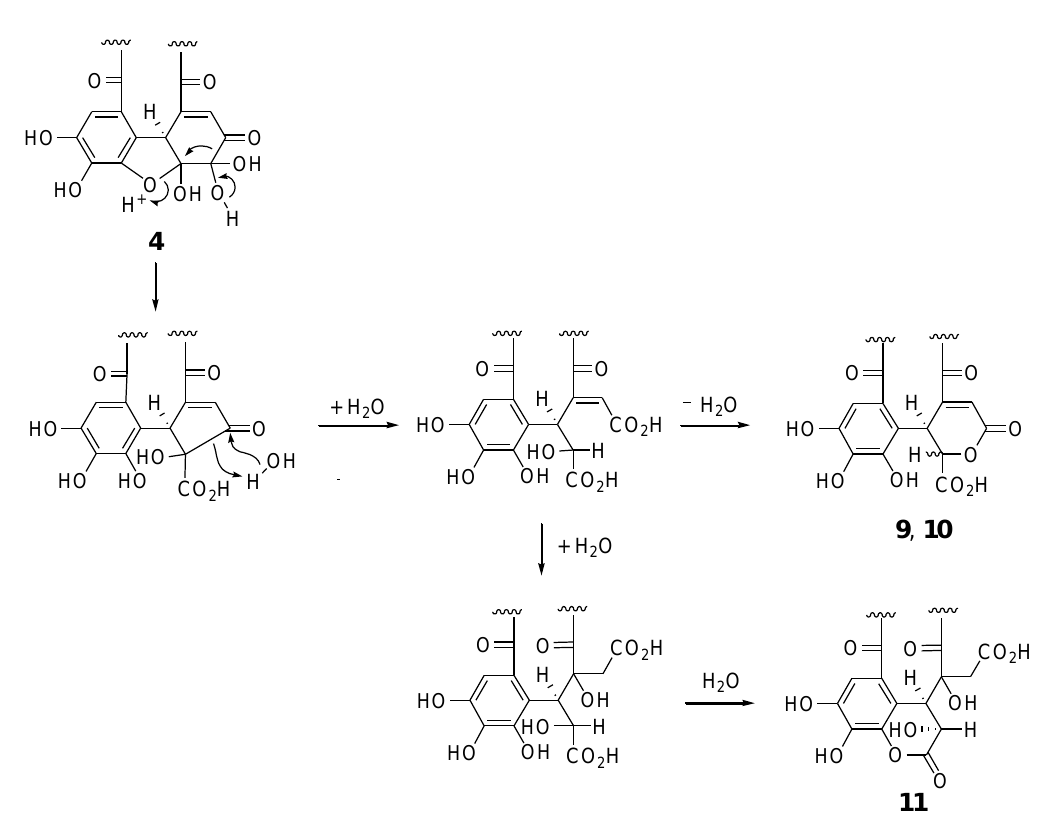
Figure 5. ( a ) Structure and selected HMBC correlations for 11 . ( b ) A partial structure of the most stable conformer of 11 and nuclear Overhauser effect spectroscopy (NOESY) correlations of the glucose and 2,4-acyl group.